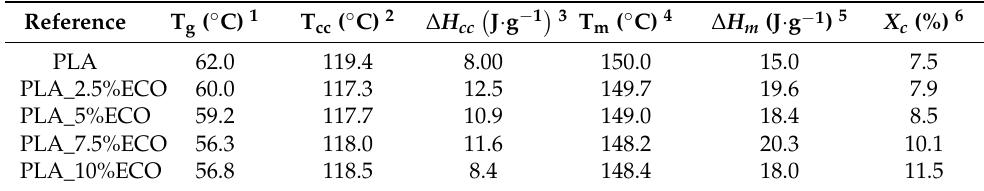
Table 3. Main thermal parameters of PLA plasticized with different ECO contents obtained using